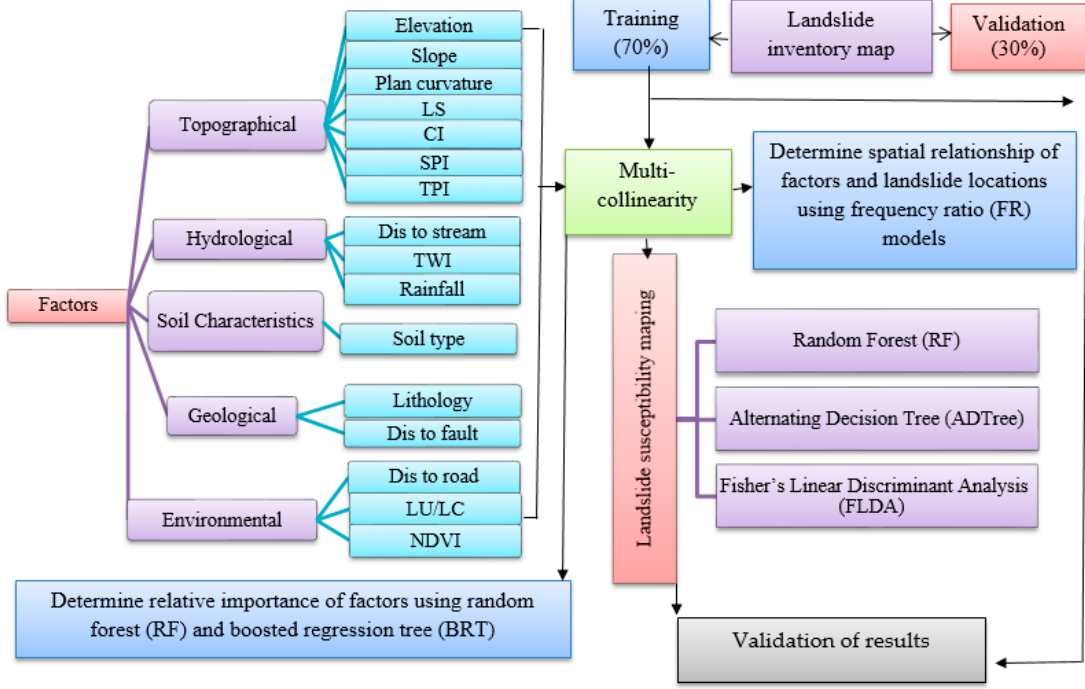
Figure 2. Flowchart of research in the study area.